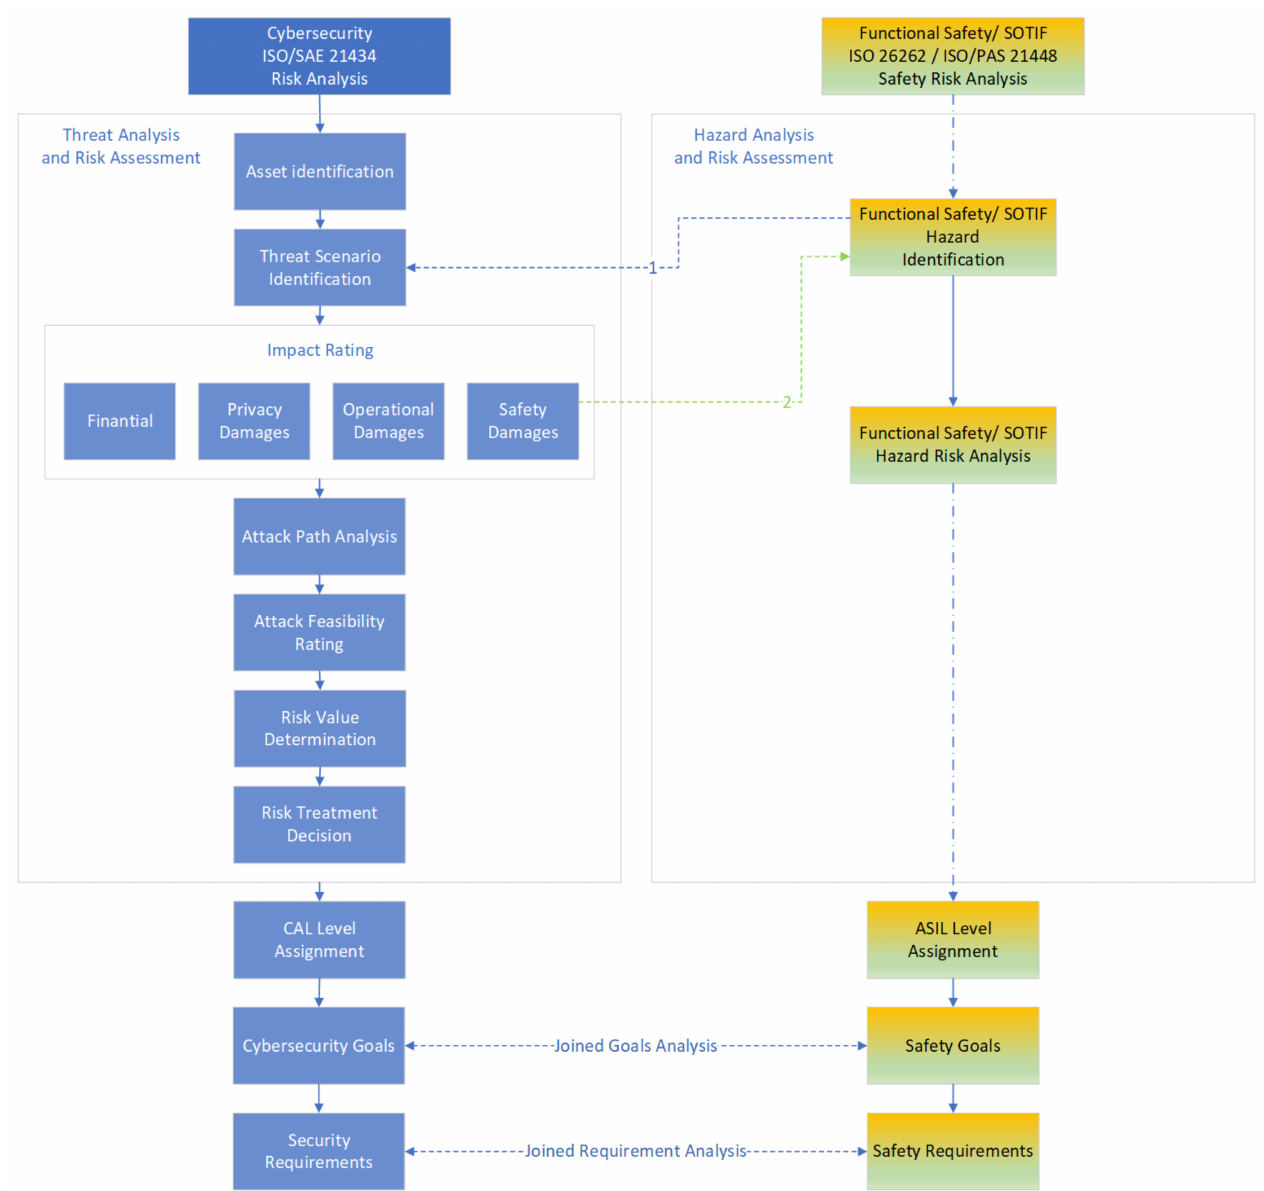
Figure 6. The impact of cybersecurity risk analysis on functional safety/SOTIF risk